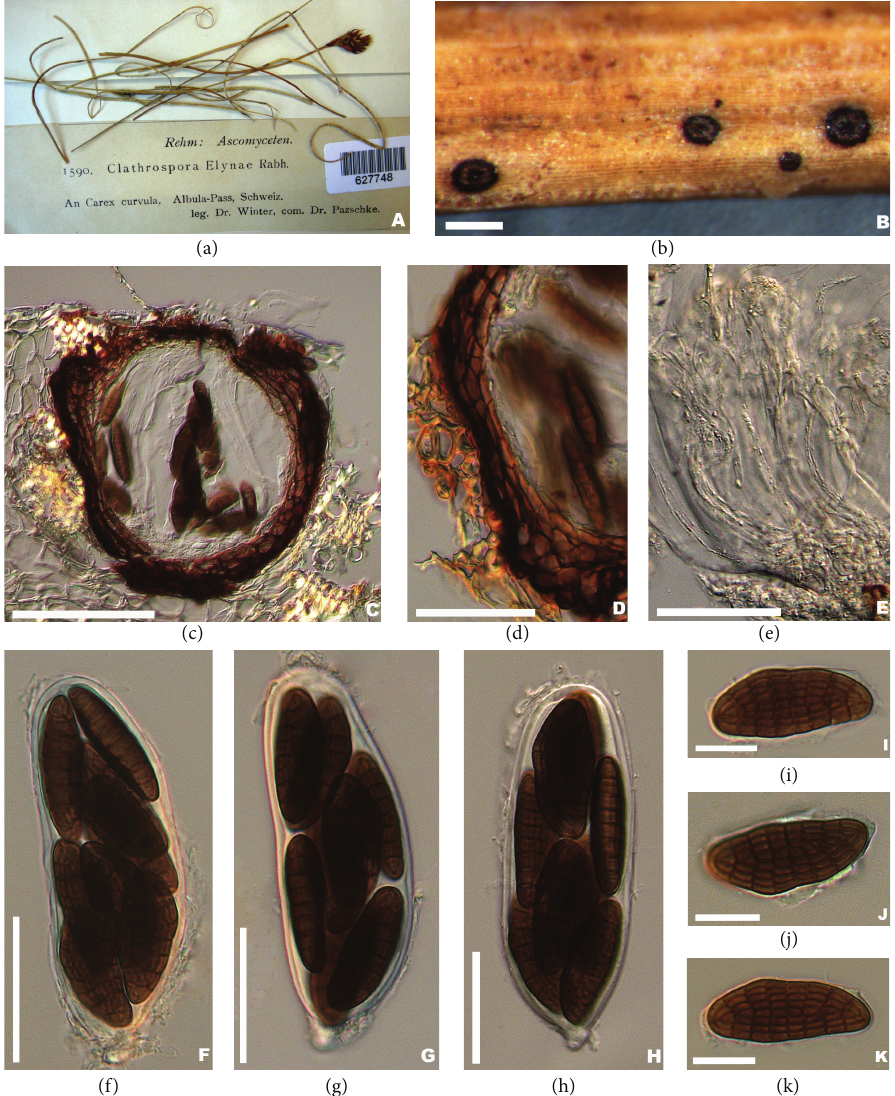
Figure 3: Clathrospora elynae (isotype). (a) Herbarium material. (b) Closeup of ascomata. (c) Section of the ascomata. (d) Closeup of the peridium (e) Hyaline, filiform, and pseudoparaphyses. ((f)–(h)) Cylindrical to clavate asci with a short pedicle and ocular chamber. ((i)–(k)) Dark brown to brown muriformascospores surroundedby a thin, hyaline mucilaginous sheath. Scale bars: (b) = 100 𝜇 m, (c) = 10 𝜇 m, ((d)–(g)) = 60 𝜇 m, and ((h)–(j)) = 30 𝜇